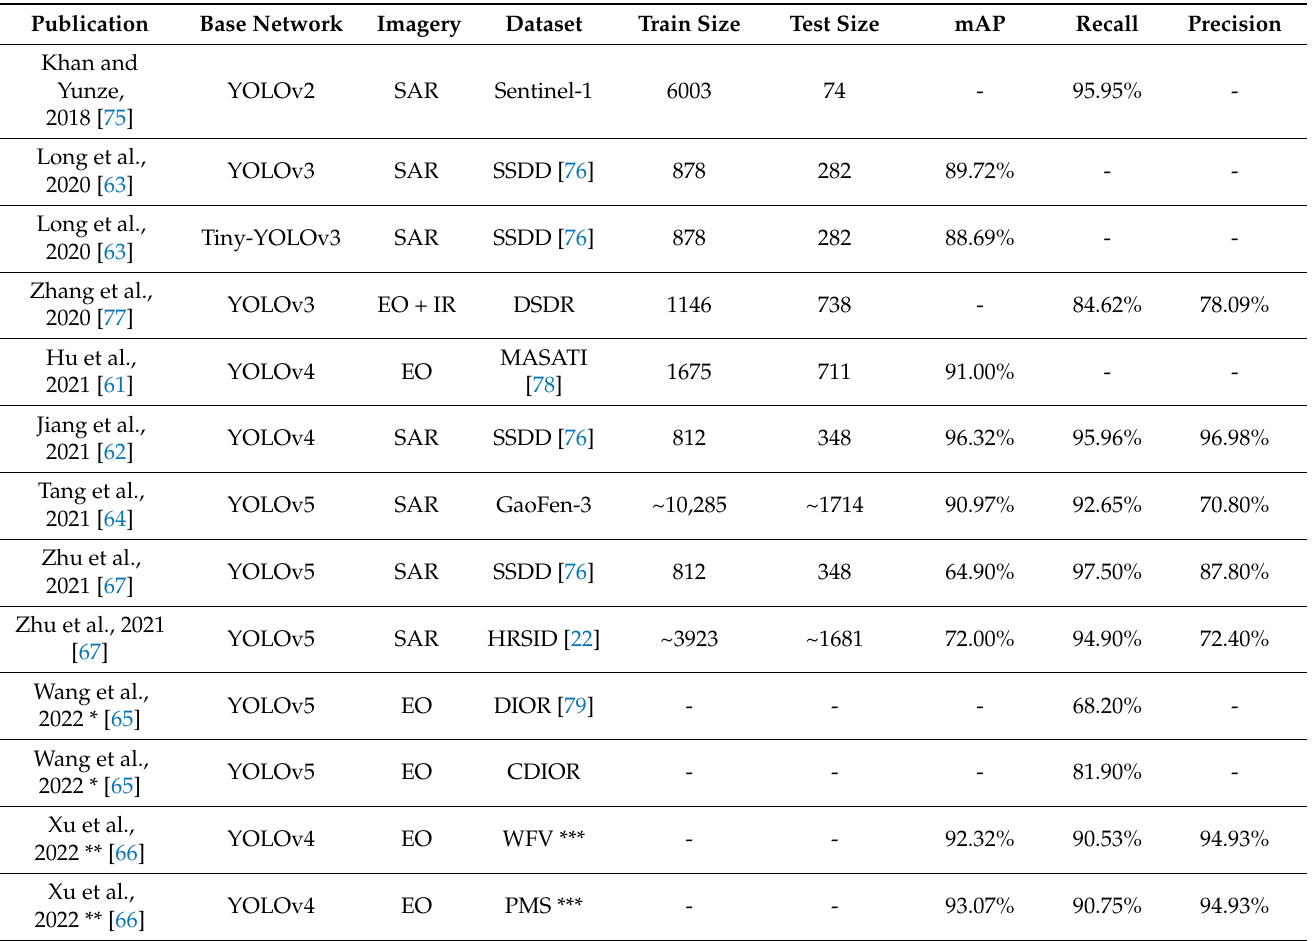
Table 4. Review of results from recent publications using YOLO networks for ship detection. All datasets without a direct citation were published as part of the listed authors’ published